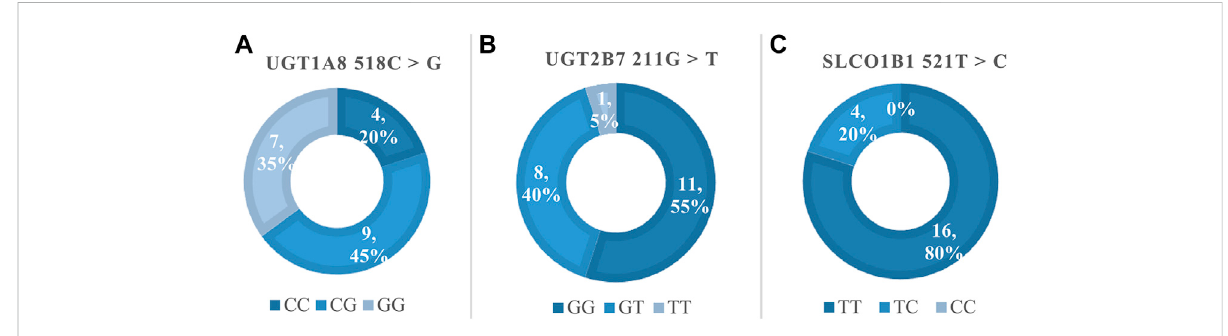
FIGURE 2 The genotype frequencies of MPA related polymorphisms. (A) Frequency of UGT1A8 518C > G, Hardy-Weinberg p > 0.05 ( χ 2 = 0.13); (B) Frequency of UGT2B7 211G > T, Hardy-Weinberg p > 0.05 ( χ 2 = 0.09); (C) Frequency of SLCO1B1 521T > C, Hardy-Weinberg p > 0.05 ( χ 2 =